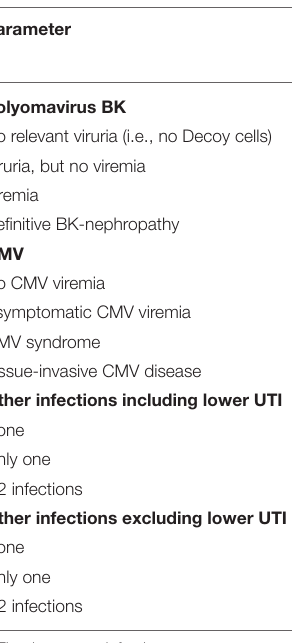
parameters. Recipients in the deceased donor and H2W groups